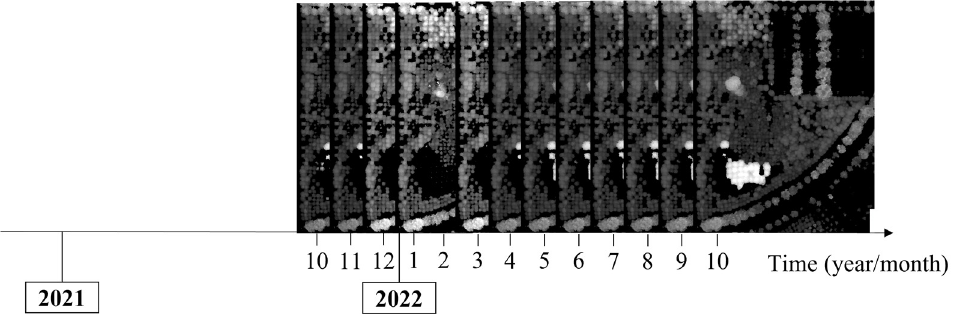
Figure 7. The CHM data used for tree height growth extraction. Table 4. Results of tree height growth in different